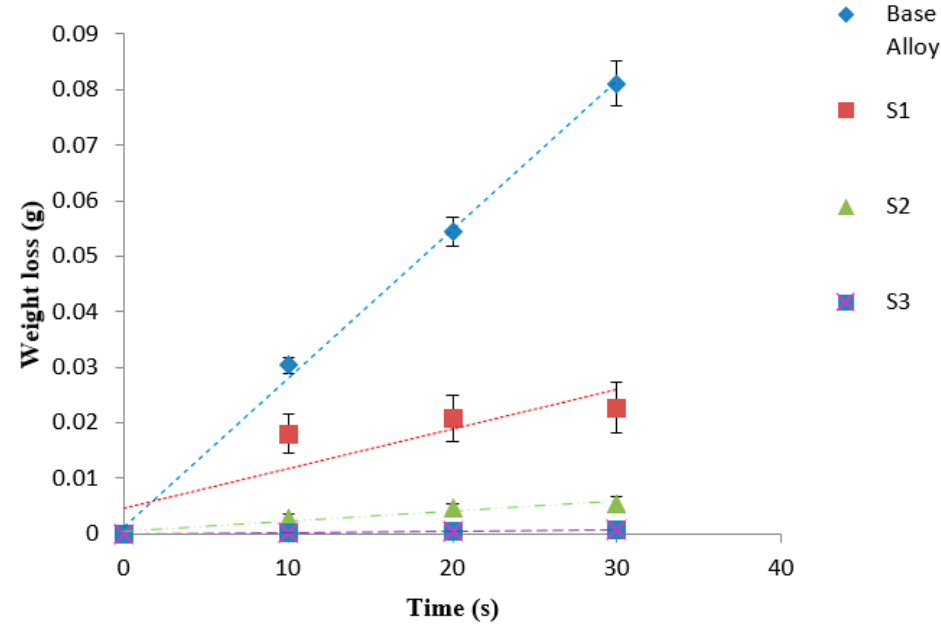
Figure 20. Weight loss of as-cast alloy and the deposited layer of samples 1, 2, and 3.